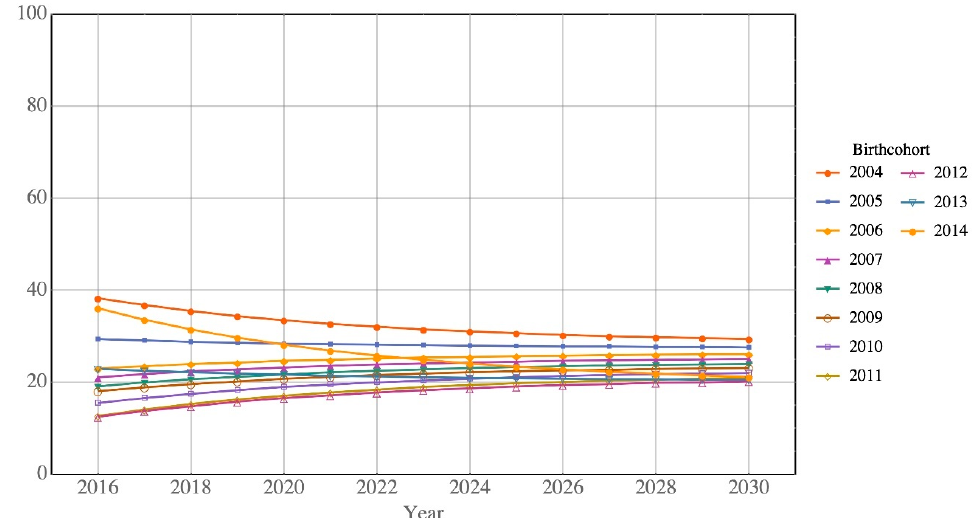
Figure 4. Predicted return rates of Type A children by birth cohort.